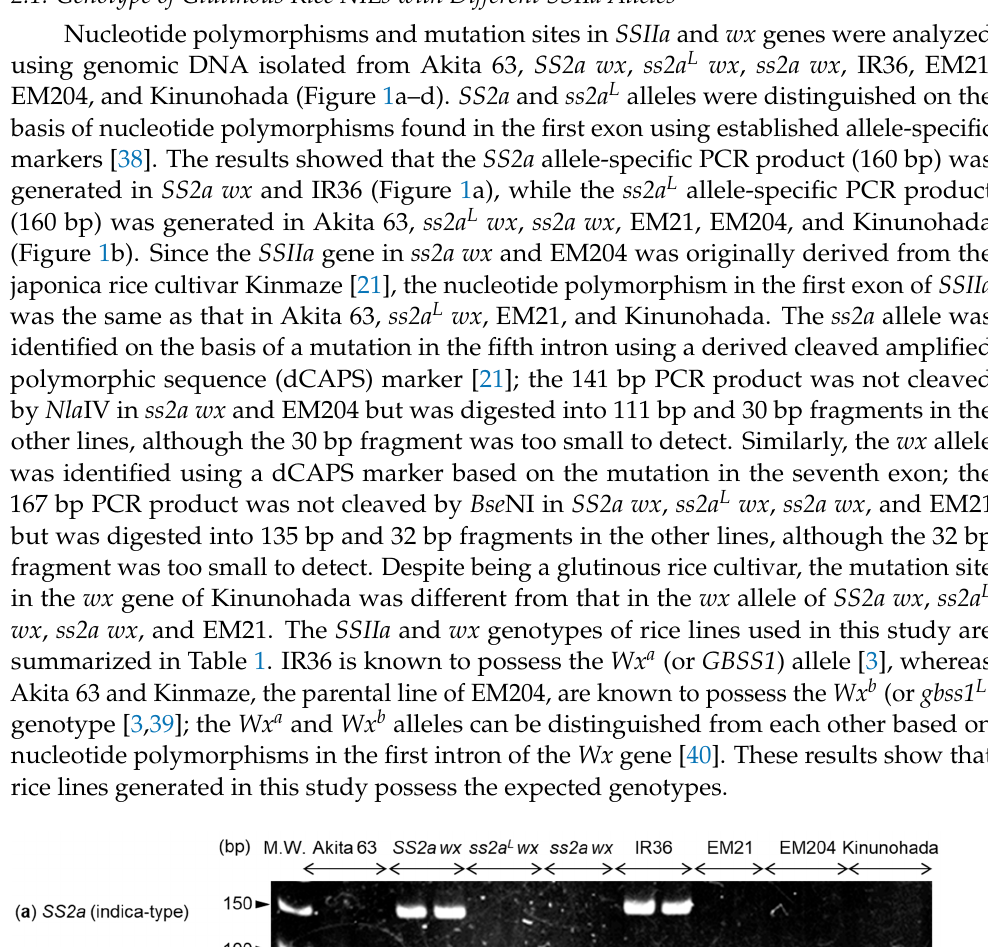
Table 1. Summary of SSIIa and Wx genotypes in rice lines